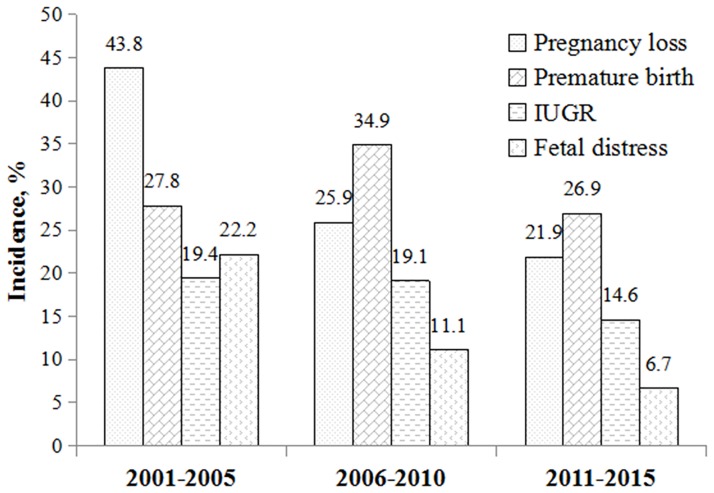
The rate of adverse pregnancy outcomesin women with SLE over the past 15 years.